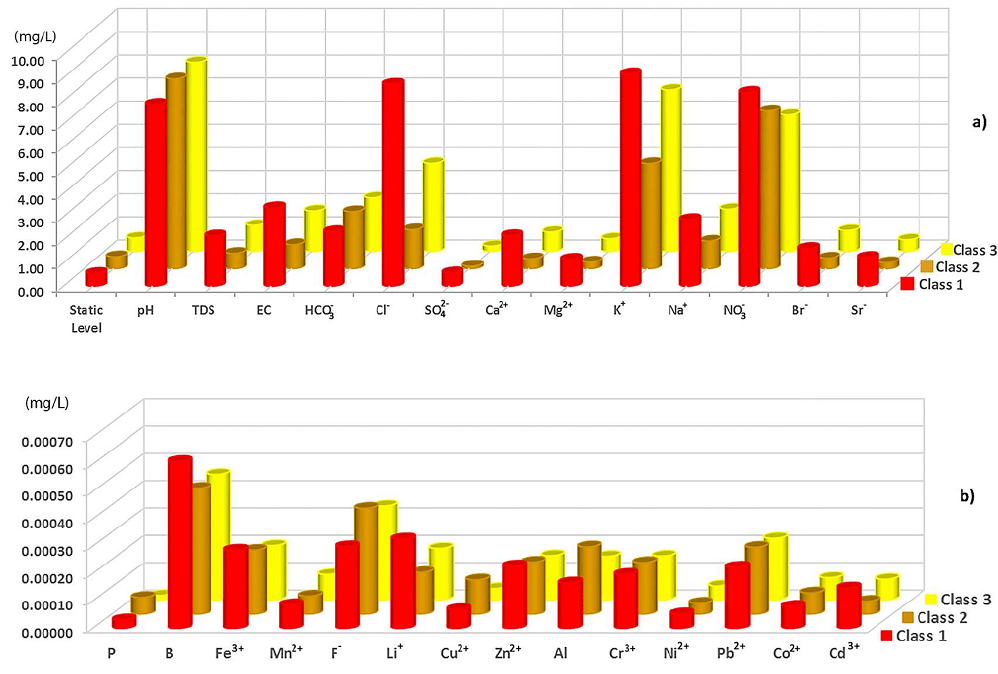
Figure 7. Clustering wells (class 1, class 2 and class 3), related to the hydrogeochemical dataset resulted. ( a ) Parameters mainly linked to salinity ( b ) Parameters linked to heavy metals